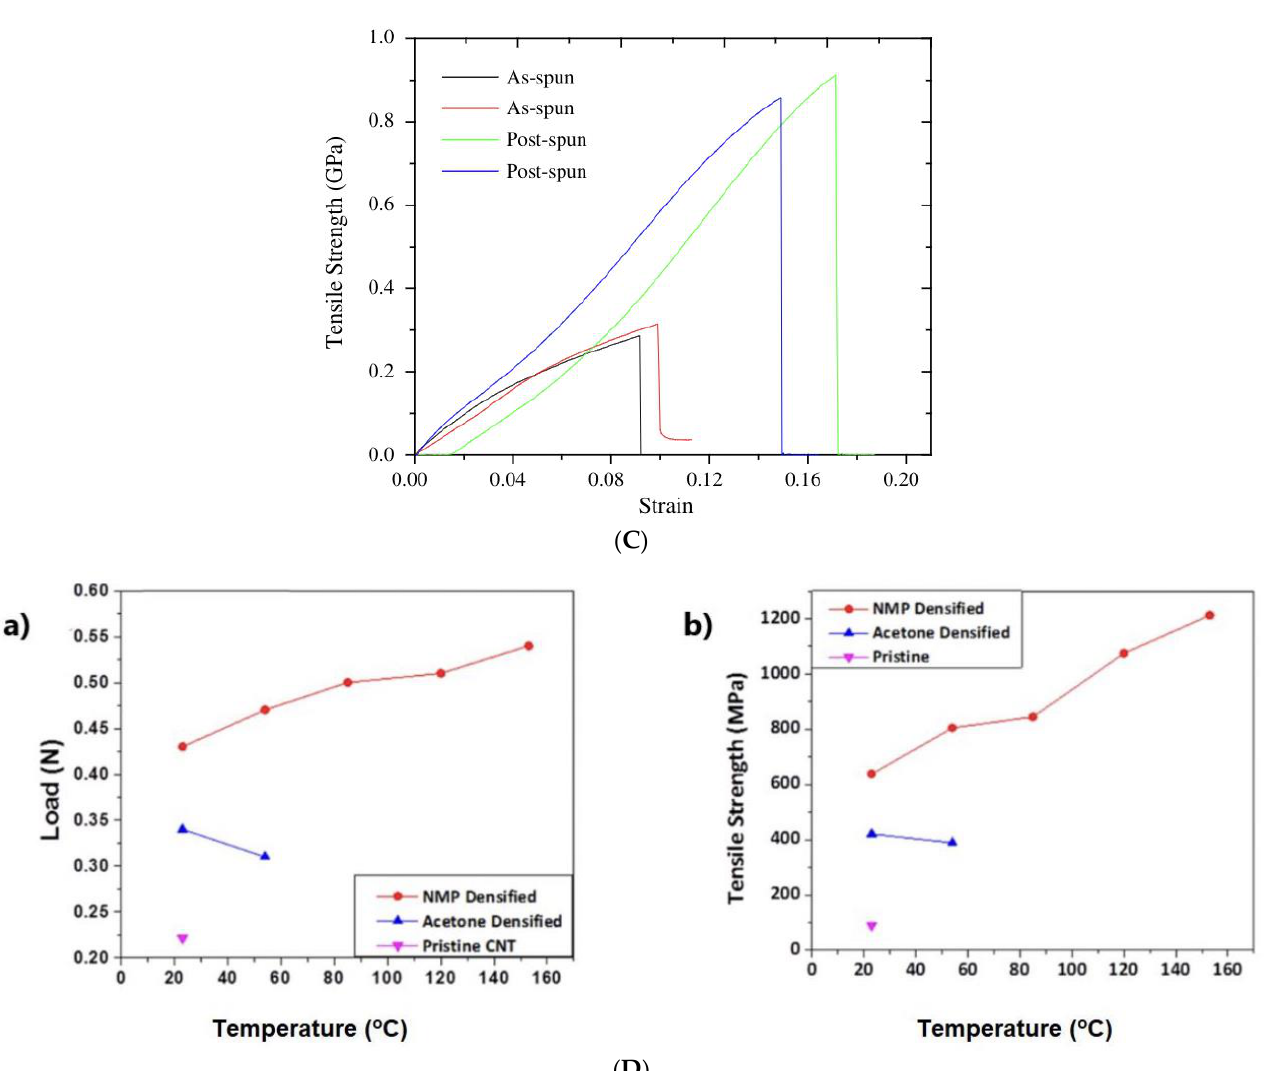
Figure 7. ( A ) Schematic of the thermal CVD process for the CNT array. ( B ) Schematic of the spinning of CNT fibers from the CNT forest array. ( C ) Schematic of as-spun fiber and post-spun fibers and comparison of the tensile strengths of “as-spun” and “post spun” CNT fibers. Reprinted with permission from [38] ( D ). Comparison of the mechanical ( a ) load-bearing and ( b ) tensile strengths of the pristine CNT fiber and the post-densified fiber with different solvents and temperatures. Reprinted with permission from [42].